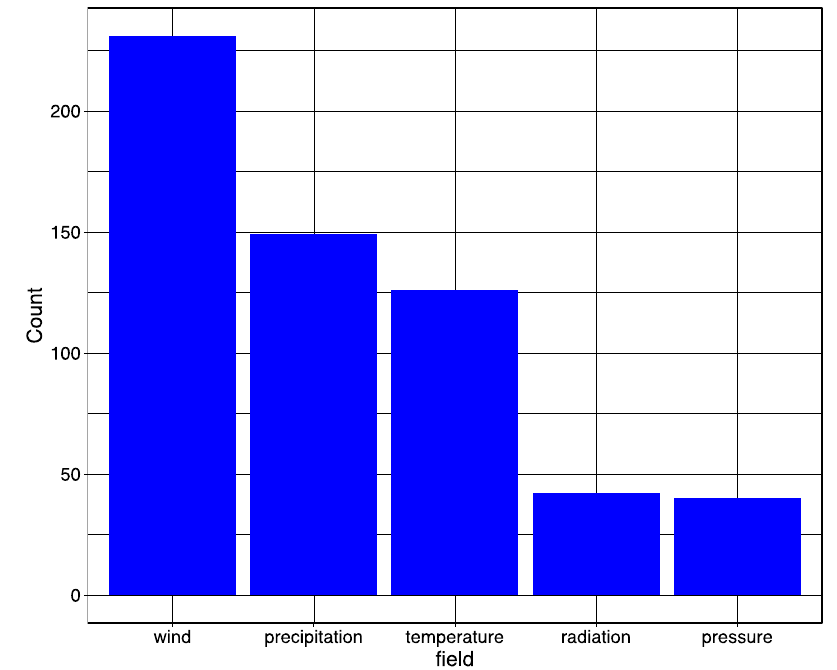
Figure 4. Most common meteorological fields in NWP-related articles.